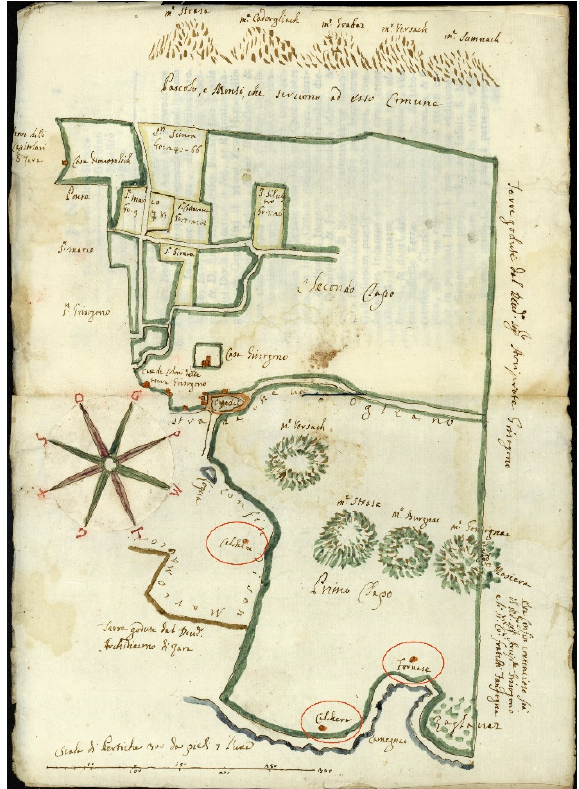
Figure 8. Cartographic depiction (red ellipses) of lime kilns in Lukoran on the island of Ugljan, 1736.